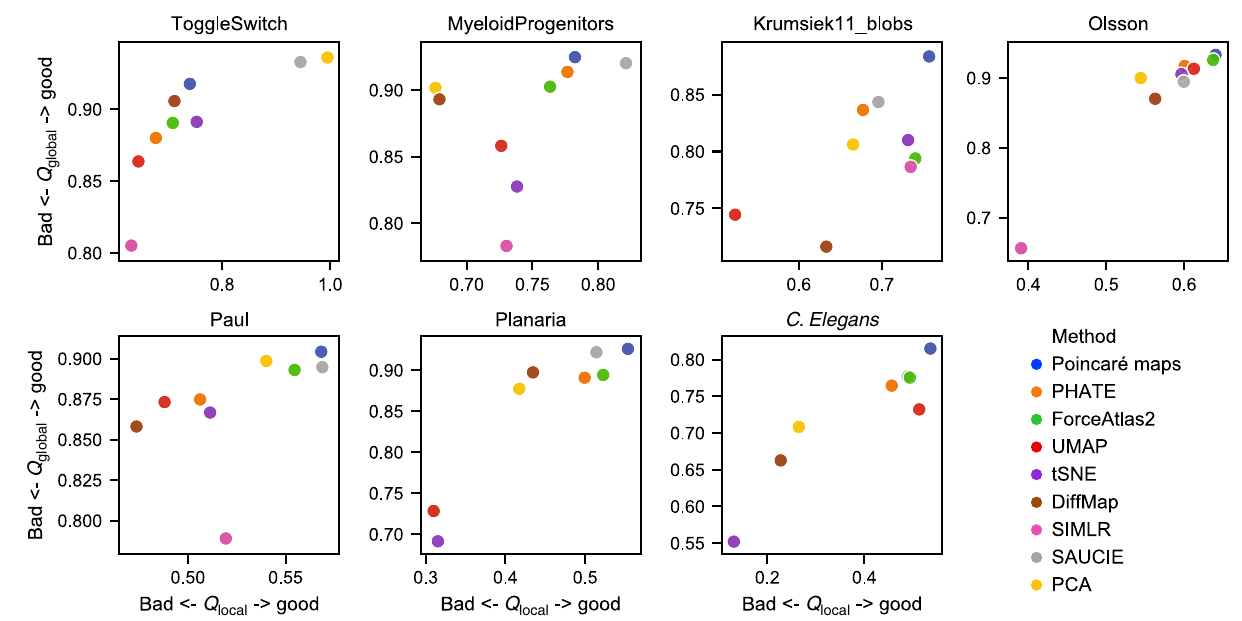
Fig. 2 Comparison of embedding quality metric (best case) for various datasets. Poincaré maps perform consistently well on all synthetic and real-world datasets in our evaluation. Planaria and C. elegans datasets — which exhibit the highest complexity in terms of number of branching trajectories — are datasets where Poincaré maps perform signi fi cantly better than other